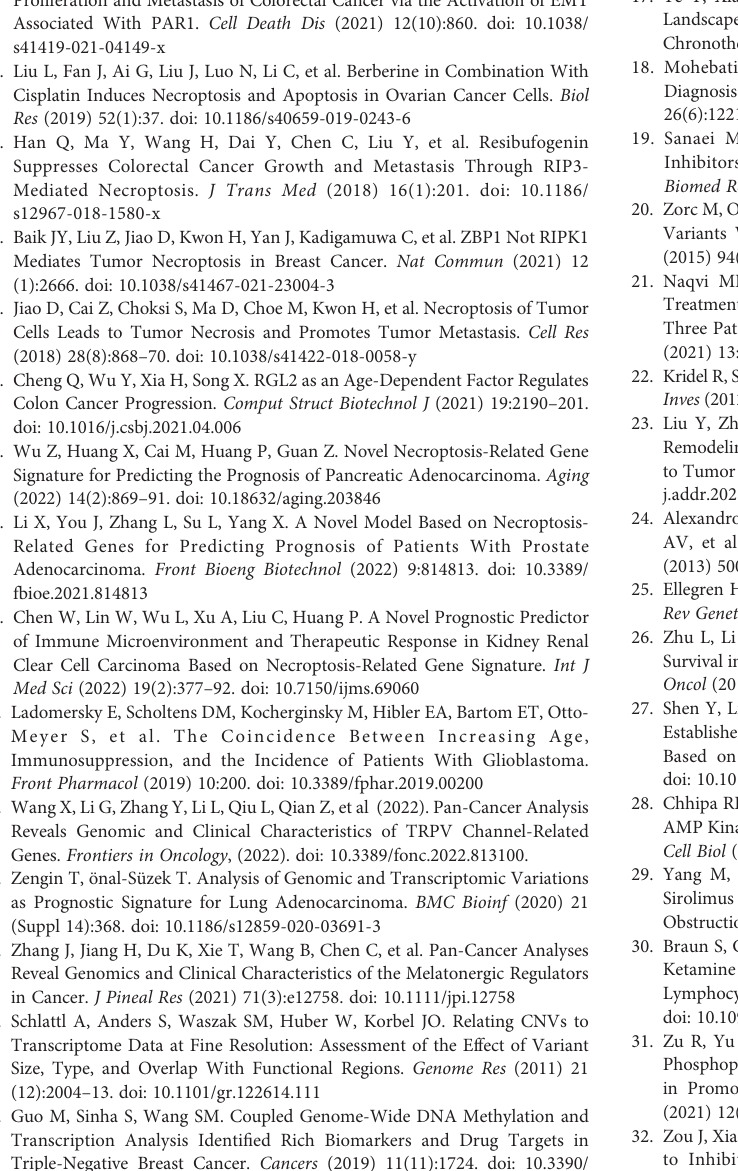
Supplementary Figure 13 | Analysis of the tumor microenvironment. Colors represent positive and negative correlations. Numbers represent Pearson ’ s coef fi cient. Supplementary Figure 14 | The association between GSVA score and activity of cancer-related pathways in selected cancers. *: P value ≤ 0.05; # FDR ≤ 0.05. Supplementary Figure 15 | The association between GSVA score and immune cell type in selected cancers. *P value ≤ 0.05; # FDR ≤ 0.05. Supplementary Table 1 | The list of abbreviations. Supplementary Table 2 | Univariate analysis and multivariate